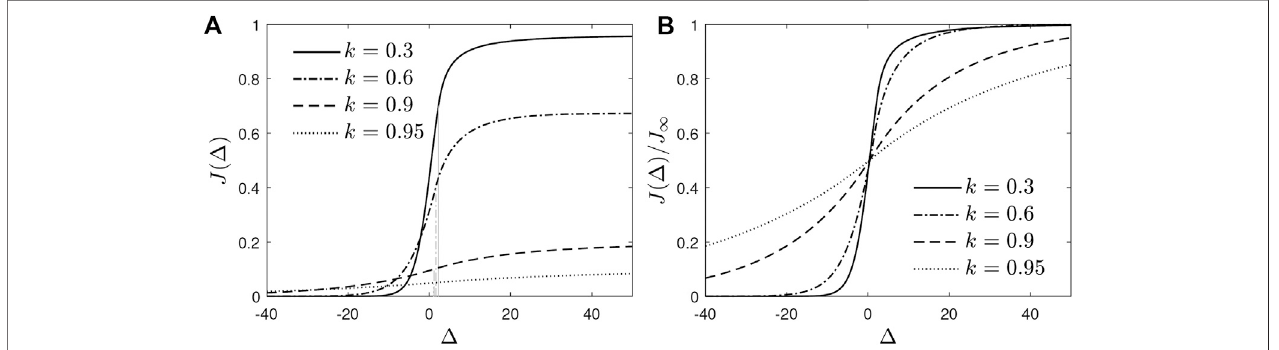
FIGURE 2 | (A) Cumulative number J ( Δ ) for different values of k according to Eq. 10 . The vertical gray lines starting at the Δ -axis indicate the respective values of Δ ( k ) . (B) Same as in (A) , divided by the fi nal J ∞ . s